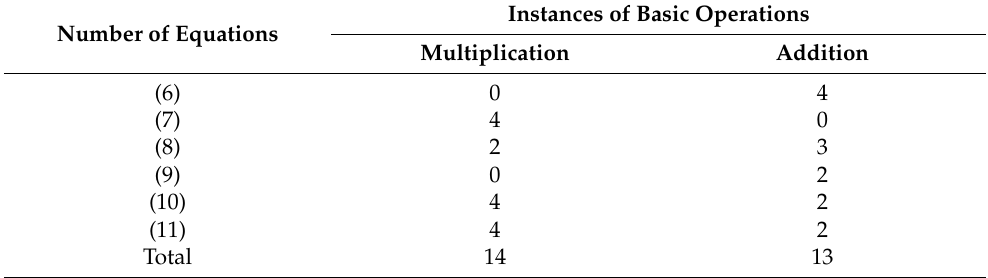
Table 1. Instances of Basic Operations of TeCVP.